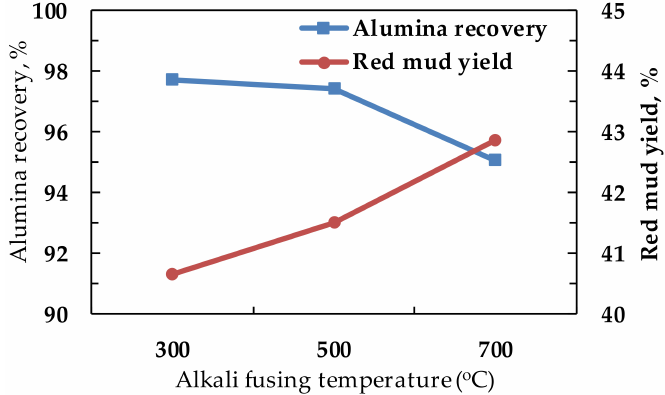
Figure 3. The influence of fusion temperature on alumina extraction and the yield of red mud.